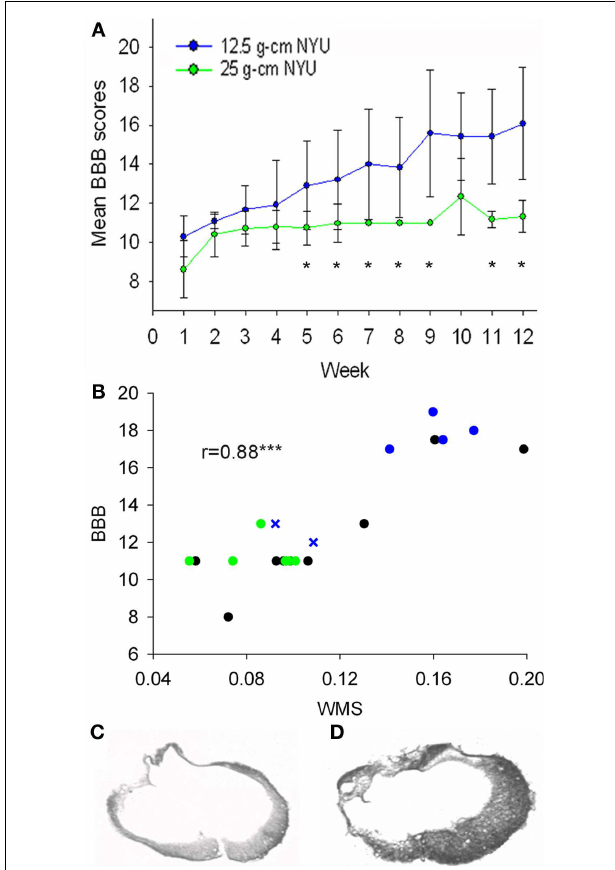
FIGURE 1 | Injuries were characterized using BBB scores to assess hindlimb locomotor function and white matter sparing (WMS) at epicenter using EC stain. (A) BBB scores of groups that received 12.5gcm (blue) or 25gcm (green) NYU injuries. Starting at week 5, a significant difference was observed between the two injury severities. Both groups were significantly different ( p < 0.05) from controls (not shown) at all time points. (B) White matter sparing at epicenter ( x axis) plotted vs. BBB score. Black dots represent 6week values. Green dots represent 12week, 25gcm injured animals. Blue x represent the two animals from the 12-week, 12.5gcm group with the lowest BBB scores within the group. Blue dots represent the four animals from the 12-week, 12.5gcm group with the highest BBB scores within the group. (C) Image taken from a 12.5gcm contused animal showing a laterally-symmetrical injury pattern at the epicenter. Note the difference from (D) , which was taken from an animal that also received a 12.5gcm spinal cord contusion but which yielded an asymmetrical injury at epicenter. * p < 0.05, *** p <